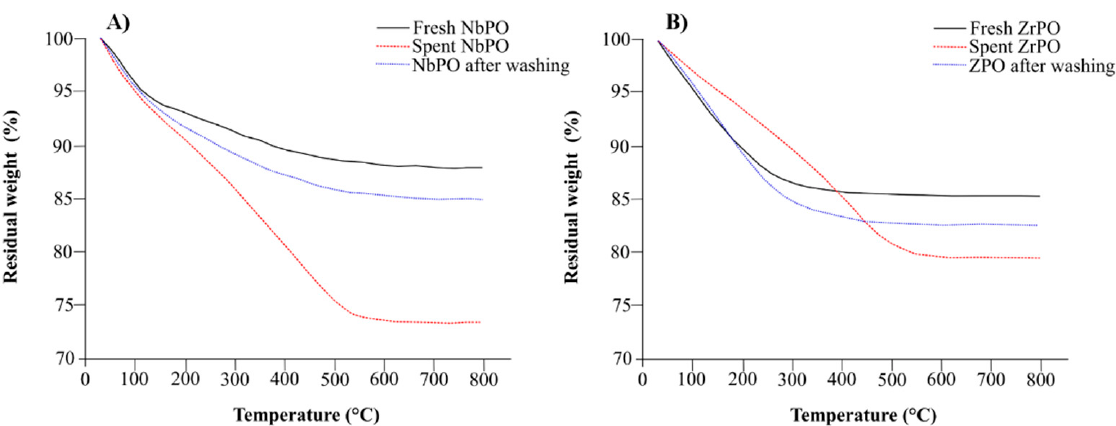
Figure 6. TGA analysis: ( A ) fresh, spent and washed NbPO; ( B ) fresh, spent and washed ZrPO.